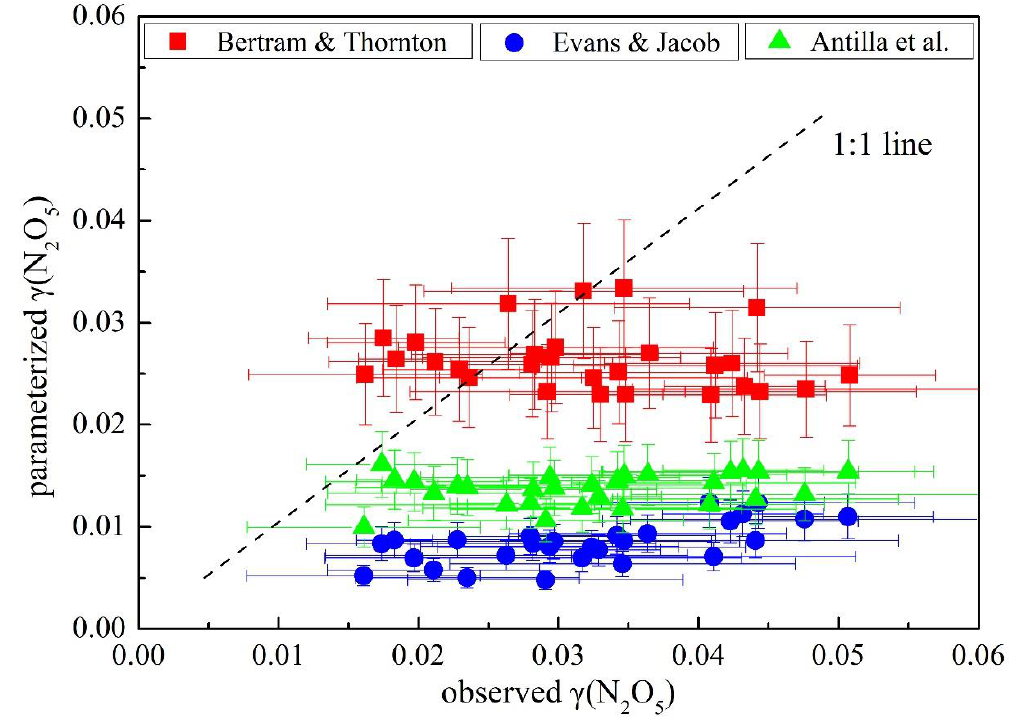
Figure 5. The relationship of parameterizations of γ (N 2 O 5 ) to observed γ (N 2 O 5 ) in urban air masses. Error bars of the observed γ (N 2 O 5 ) represents the standard deviation of the 12 γ (N 2 O 5 ) values obtained within one hour. Error bars of the parameterized γ (N 2 O 5 ) denote propagated uncertainty.